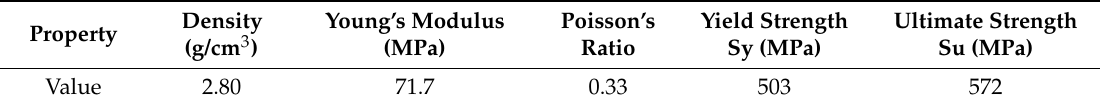
Table 1. Mechanical Properties: Aluminum 7075-T6.